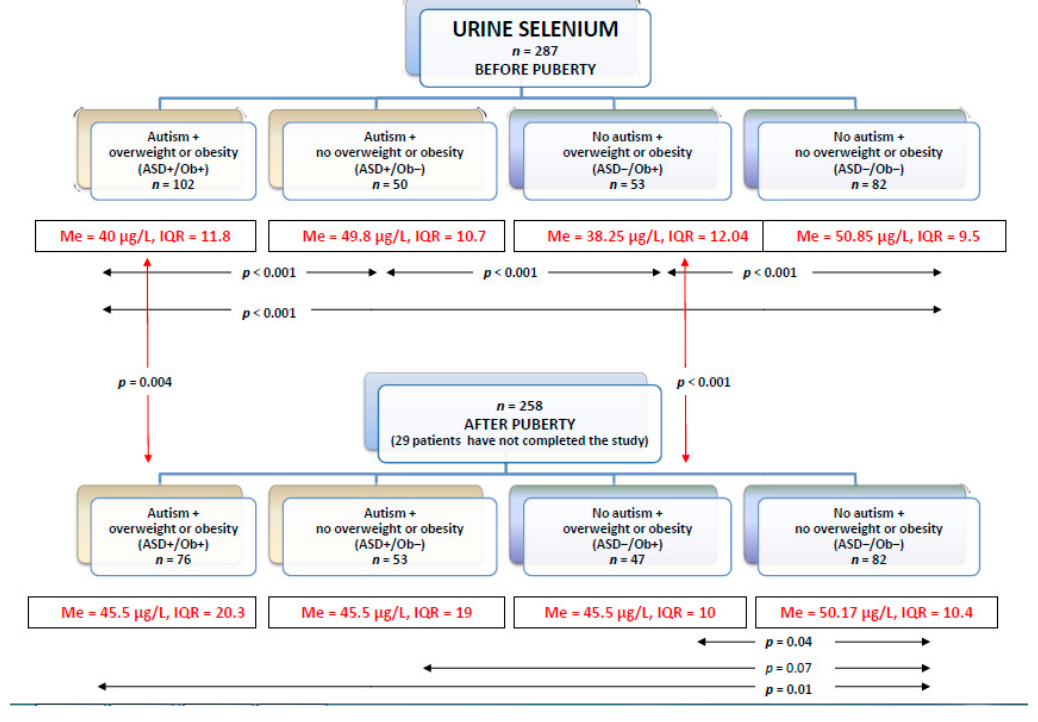
Figure 3. 24 h urinesample selenium levels in each group before and after puberty (Me—median, IQR—interquartile range).